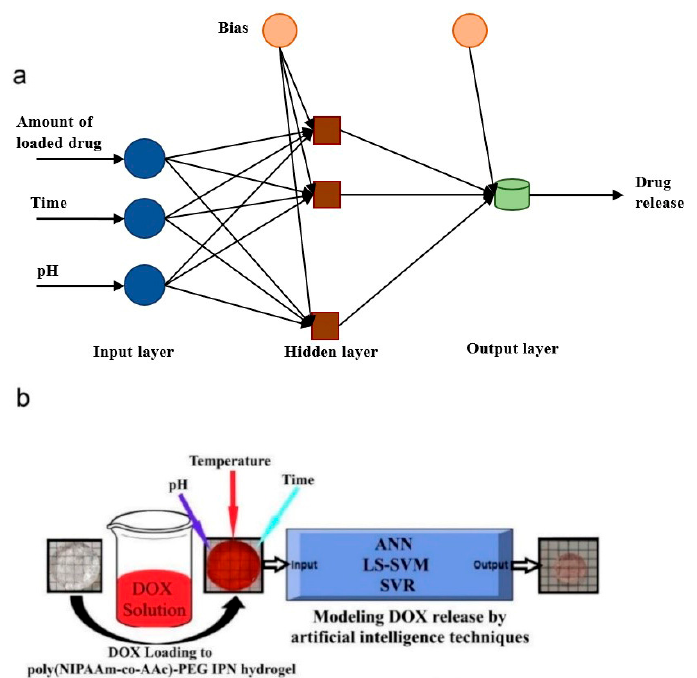
Figure 1. ( a ) Architecture of G-ANN in the analysis of release procedure. ( b ) Using ANNs, SVR and LS-SVM models for modeling the release behavior of DOX from temperature and pH responsive poly(NIPAAm-co-AAc)-PEG IPN hydrogel [34].